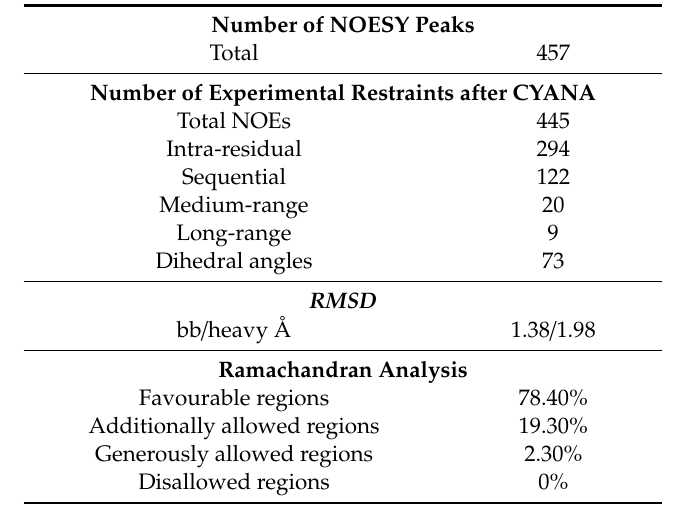
Table 1. Statistics for the structural calculation of the NMR Ensemble of 737-786 gp36